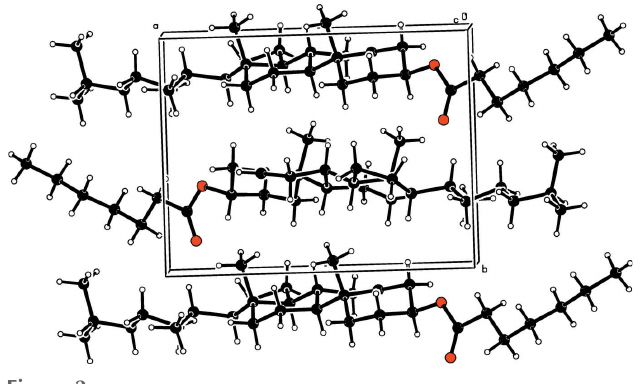
Figure 2 A partial packing diagram viewed down the c axis.